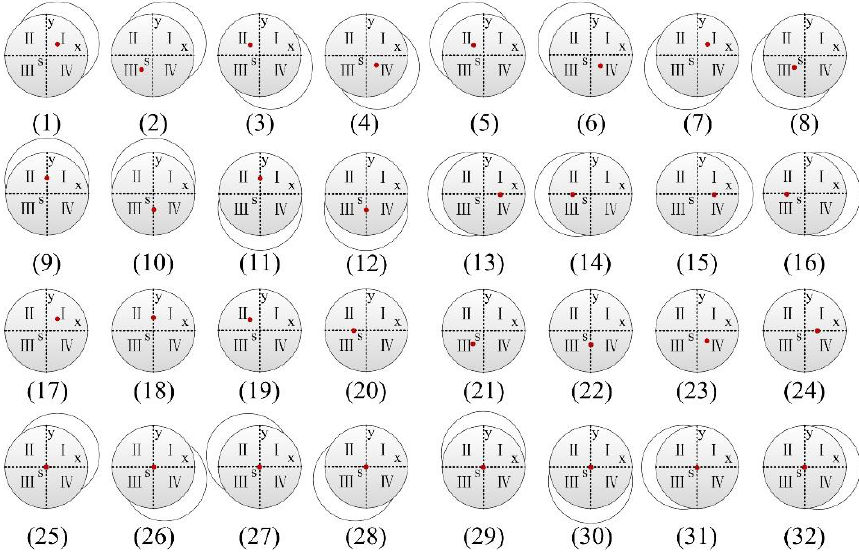
Table 1. Relationship between the attitude changes and coordinate